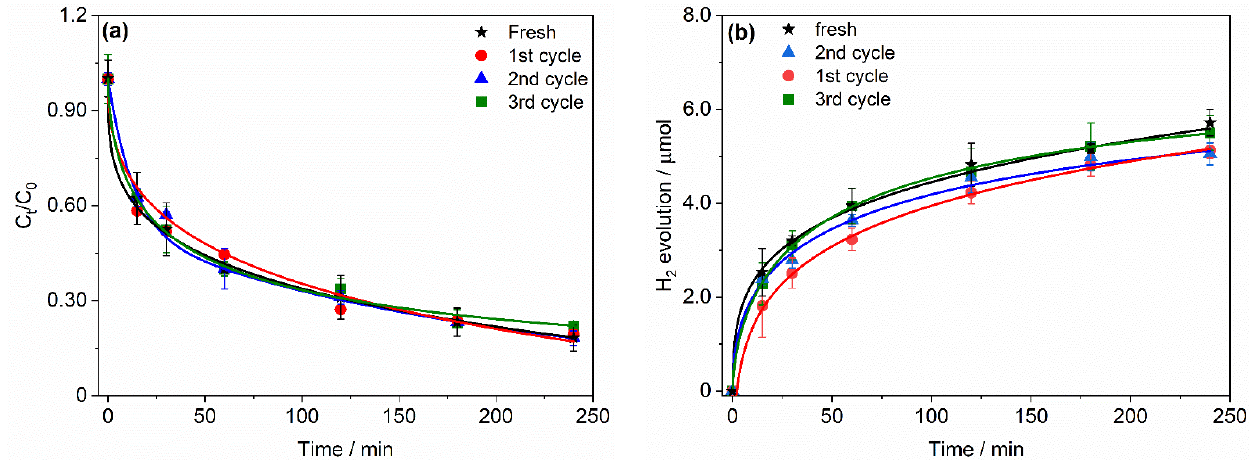
Figure 7. C t /C o for naphthalene conversion ( a ) and molecular hydrogen formation ( b ) during the photocatalytic reforming of naphthalene using recycled 0.5 wt% Pt ‐ HTiO 2 photocatalyst. Conditions: [Naphthalene] = 0.156mM, [catalyst] = 0.5 g L − 1 , T = 25 °C, 240 ‐ min illumination under simulated solar light.